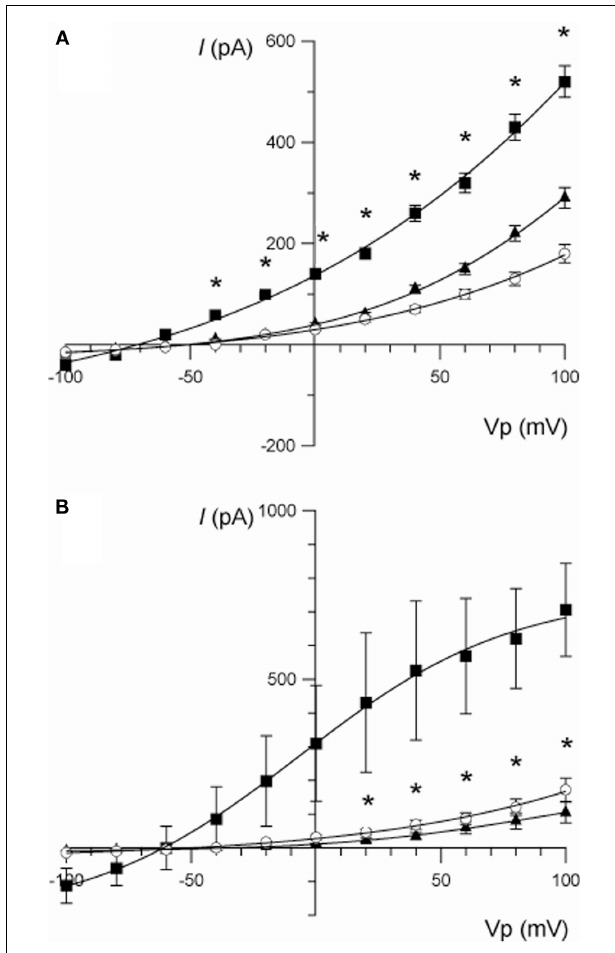
FIGURE 3 | (A) Current/voltage relationships illustrating the effect of berberine (100 μ M) on the increase in whole-cell current stimulated by forskolin (10 μ M) inT84 cells.Traces are control ( ◦ ), forskolin ( (cid:2) ), and forskolin + berberine ( (cid:3) ). Data are mean ± SEM (* P < 0.01 between the forskolin-stimulated current and berberine, n = 7). (B) Current/voltage relationships illustrating the effect of chromanol 293B (10 μ M) on the increase in whole-cell current stimulated by forskolin (10 μ M) inT84 cells. Traces are control ( ◦ ), forskolin ( (cid:2) ), and forskolin + chromanol 293B ( (cid:3) ). Data are mean ± SEM (* P < 0.01 between the forskolin-stimulated current and chromanol 293B, n =